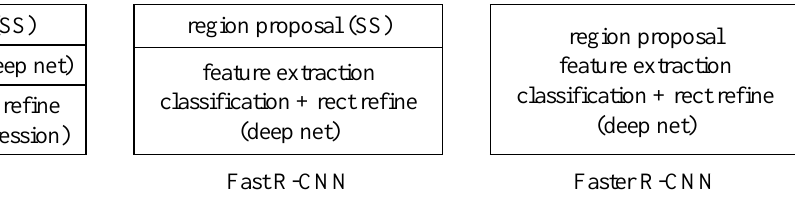
Figure 5. Evolution from R-CNN to Faster R-CNN.